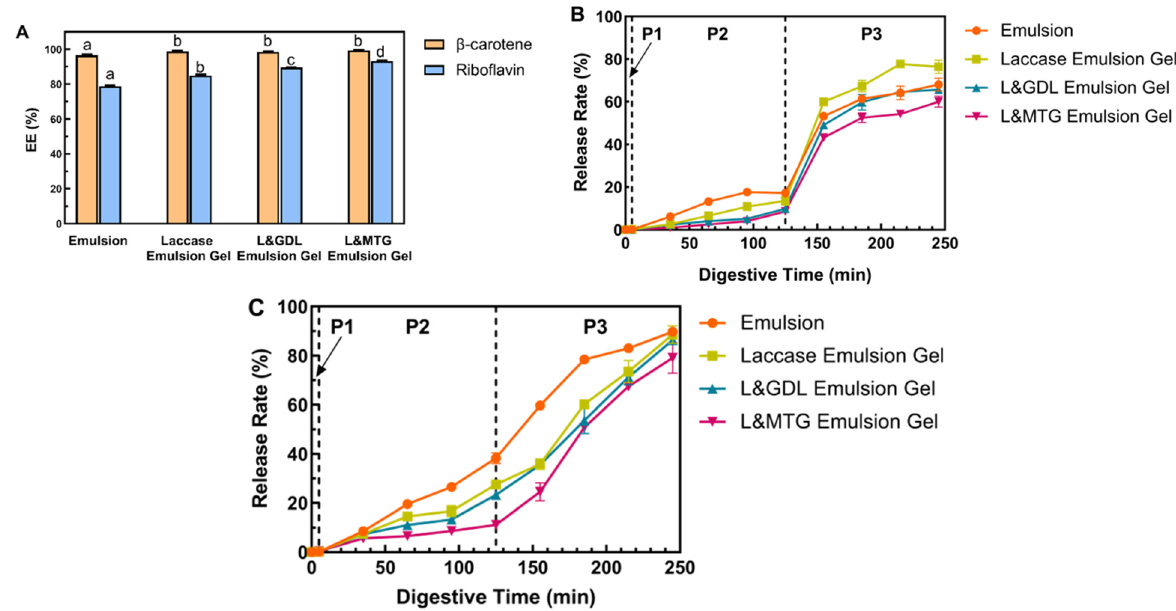
Figure 6. The embedding ( A ) and the release profiles of β‐ carotene ( B ) and riboflavin ( C ) from co ‐ loading SPI ‐ SBP emulsion gel induced by different methods. Different letters indicated significant differences among different inducing methods at p < 0.05 level. P1: Oral Phase; P2: Gastric Phase; P3: Intestinal Phase.